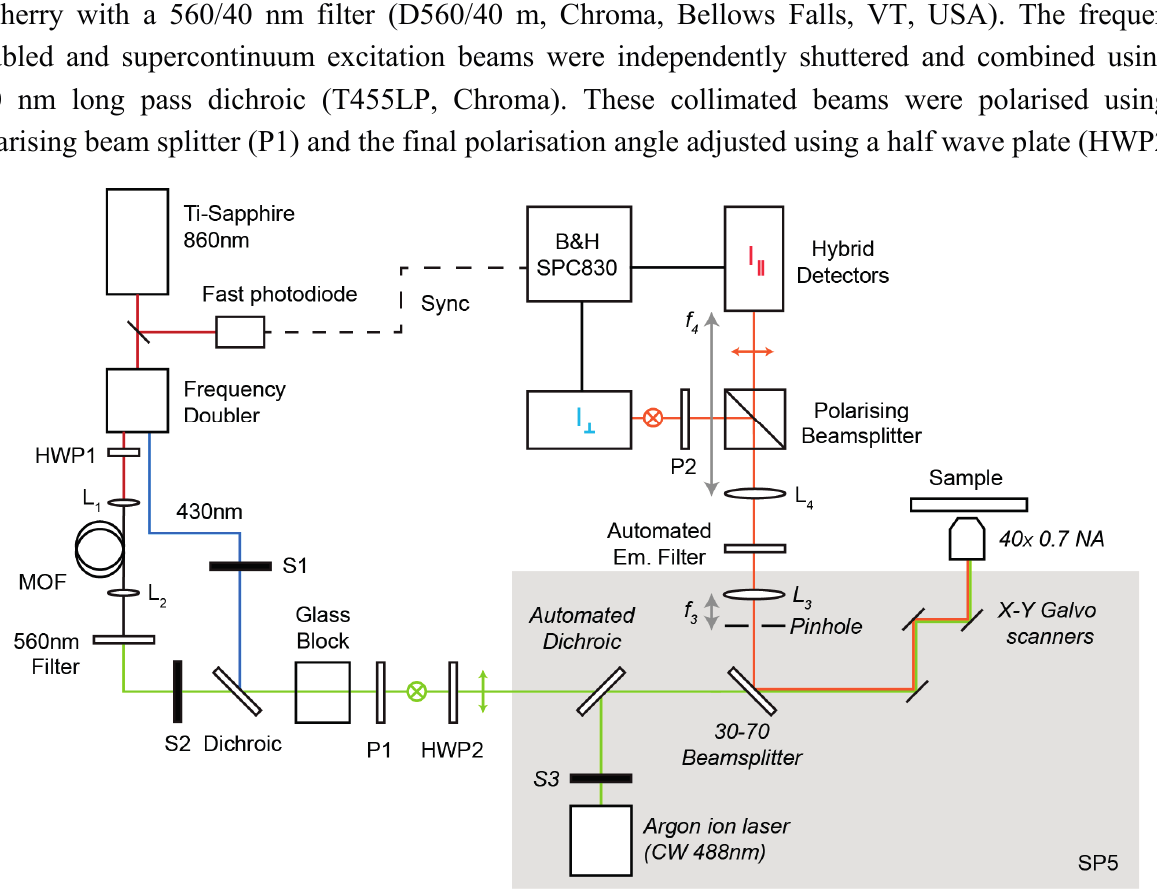
Figure 5. Schematic of the multiplexed polarisation resolved microscope described in the text. Components inside the grey area and labelled in italics are internal to the SP5 confocal microscope. Abbreviations used: HWP , half wave plate; S , shutter, P , polariser, L , lens. The focal lengths of lenses L 3 and L 3 are labelled f 3 and f 4 ,